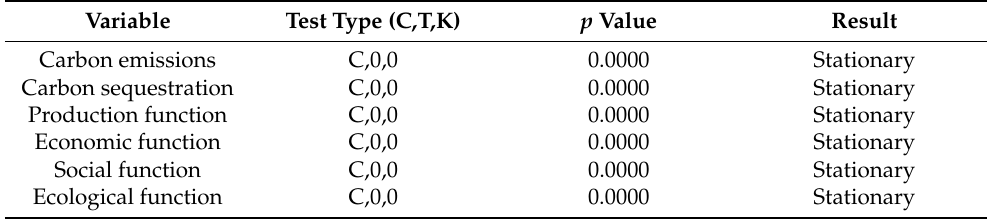
Table 3. Results of panel unit root tests.